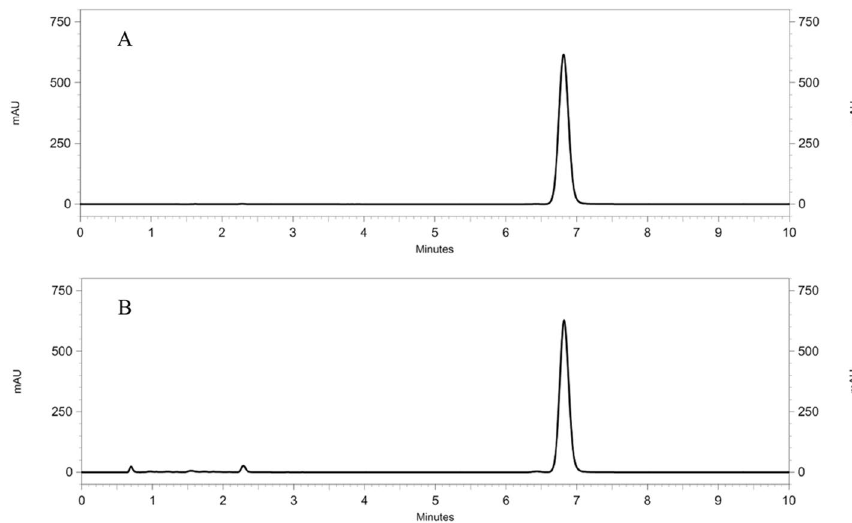
Fig. 2 HPLC chromatograms of a trans -anethole (75 μg/mL) and b extract obtained from Condition 10 (500 μg/mL). The trans -anethole was eluted at the retention time of 6.8